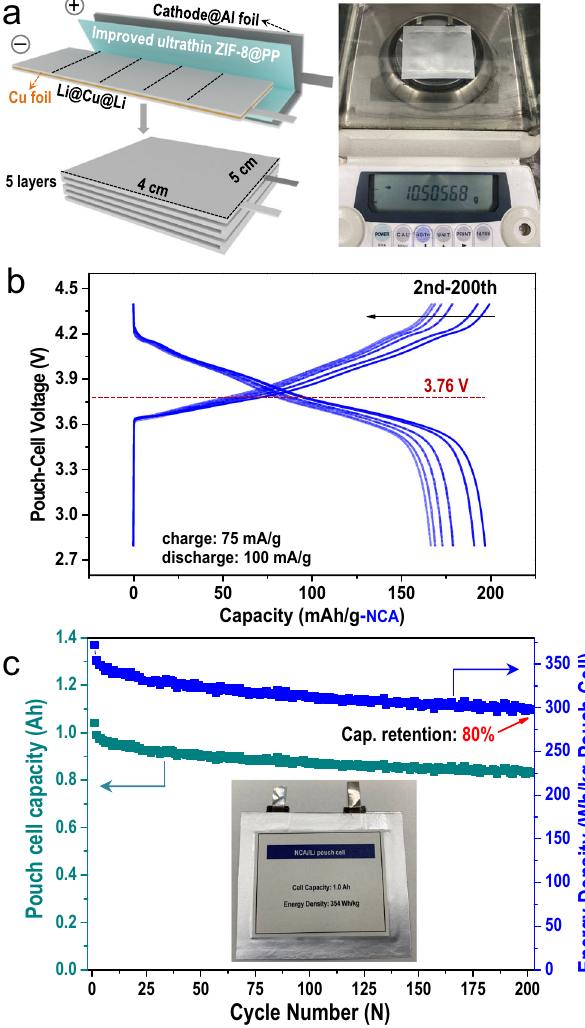
Fig. 6 | Performance andthe correspondingcell parameters for the 350Wh/kg NCA||LipouchcellassembledwiththeimprovedultrathinZIF-8@PPseparator in a typical 1mol/L LiPF 6 -EC/DMC carbonate-based electrolyte. a Schematic representation of the NCA||Li pouch-cell packing assembled with the improved ultrathin ZIF-8@PP. b Typical galvanostatic charge/discharge curves for pouch- type cell fabricated with a NCA cathode, improved ultrathin ZIF-8@PP separator, and typical 1mol/L LiPF 6 -EC/DMC carbonate-based electrolyte. c Output capacity and energy density of the 350Wh/kg NCA||Li pouch-cell assembled with the improved ultrathin ZIF-8@PP separator in a typical 1mol/L LiPF 6 -EC/DMC carbonate-based electrolyte. A digital photo ofthe pouchcellisshown in the inset for